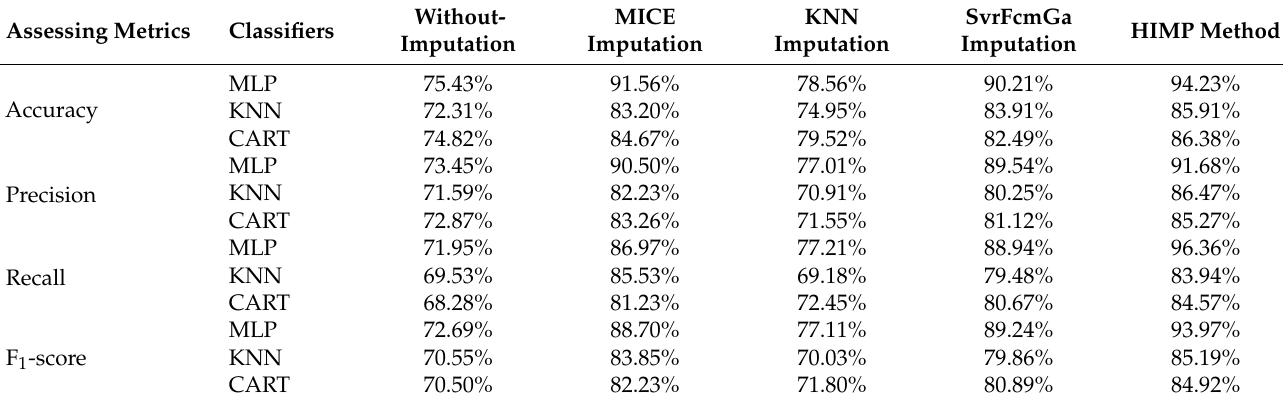
Table 4. Comparing the HIMP method with other imputation methods.